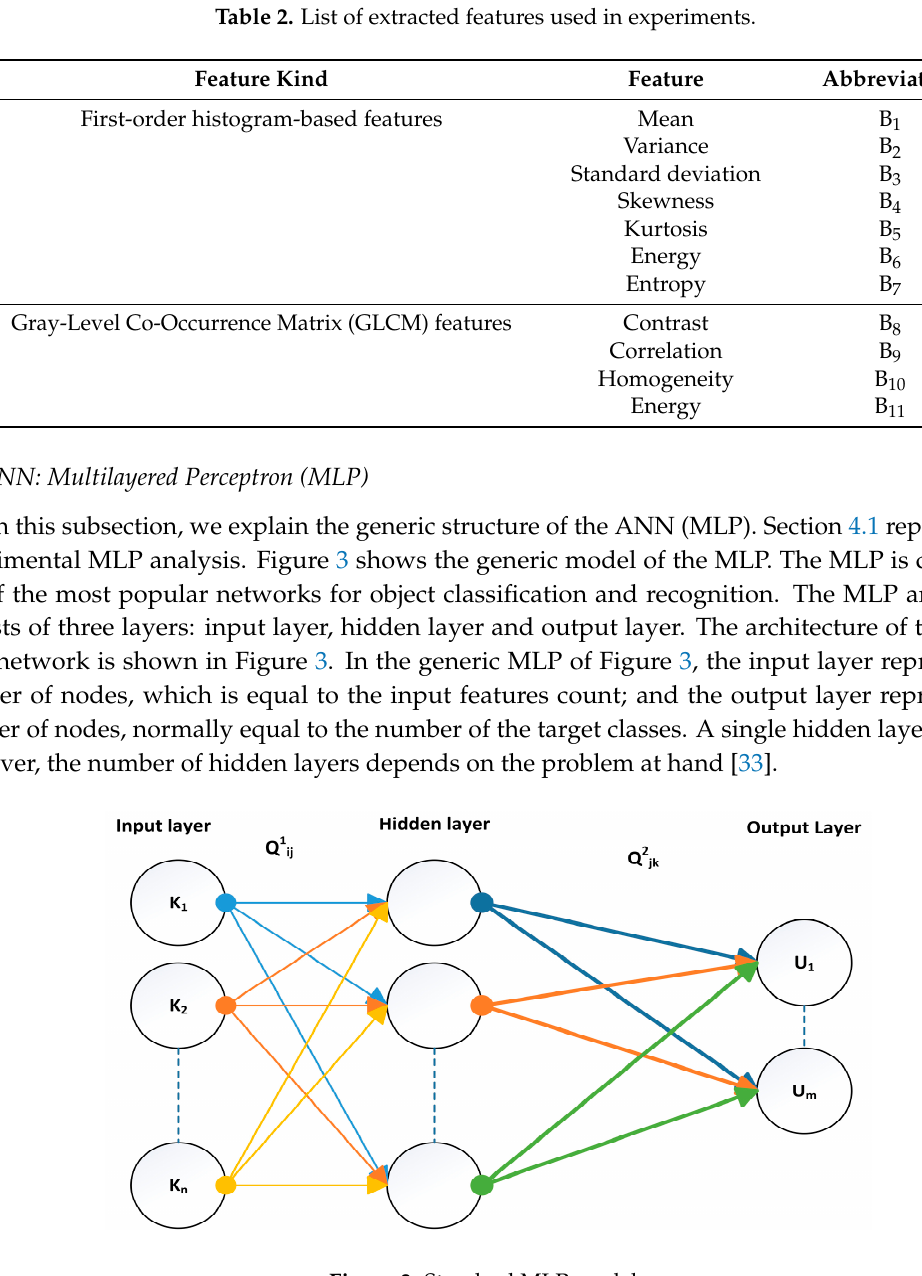
Table 2. List of extracted features used in experiments.